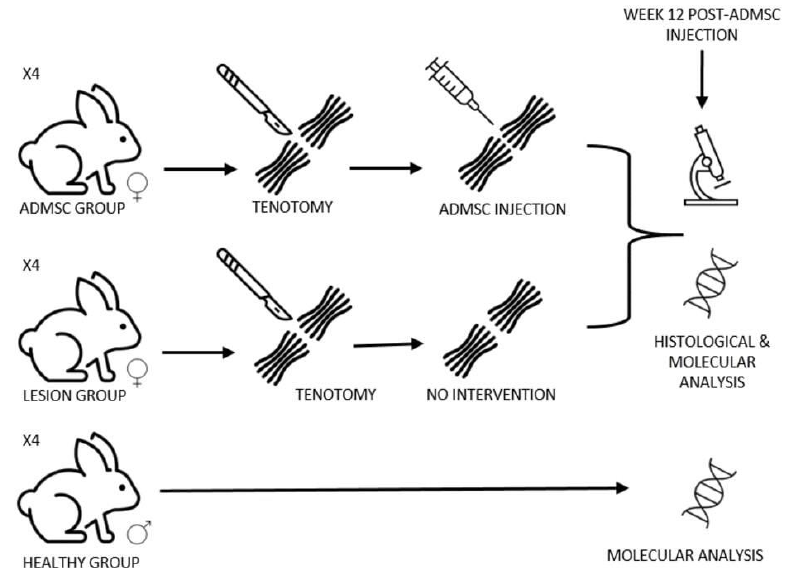
Figure 1. Workflow scheme. Eight female New Zealand white rabbits in which tenotomy was performed, were divided into two groups (four animals per group). The ADMSC group received male ADMSCs after tenotomy, whereas the lesion group remained untreated (no intervention). At Week 12, tissue biopsies of both groups were taken in order to perform histological and molecular analysis. An additional healthy group of four male rabbits was simultaneously analyzed as a